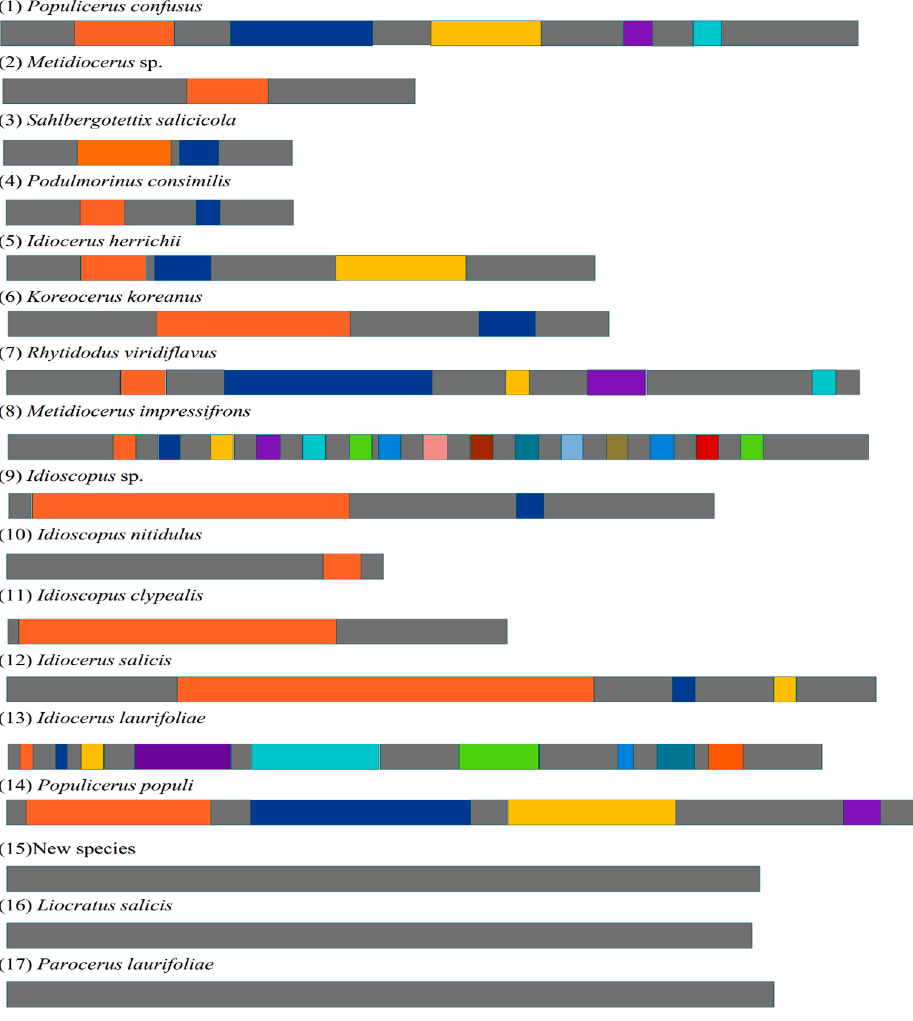
Figure 5. Types of the control region in Idiocerini, in consideration of the positions and related length of tandem repeats. Light black means the position without tandem repeats, other colors mean different tandem repeats of different species. The difference in color is just for presenting different tandem repeats of each species, and the same color of different species does not mean the same tandem repeats of them. Due to the space limit and more TRs of several species, the length of different tandem repeats was defined according to the total length of the control region of each species, and the total length of the control region was not mutually referenced.